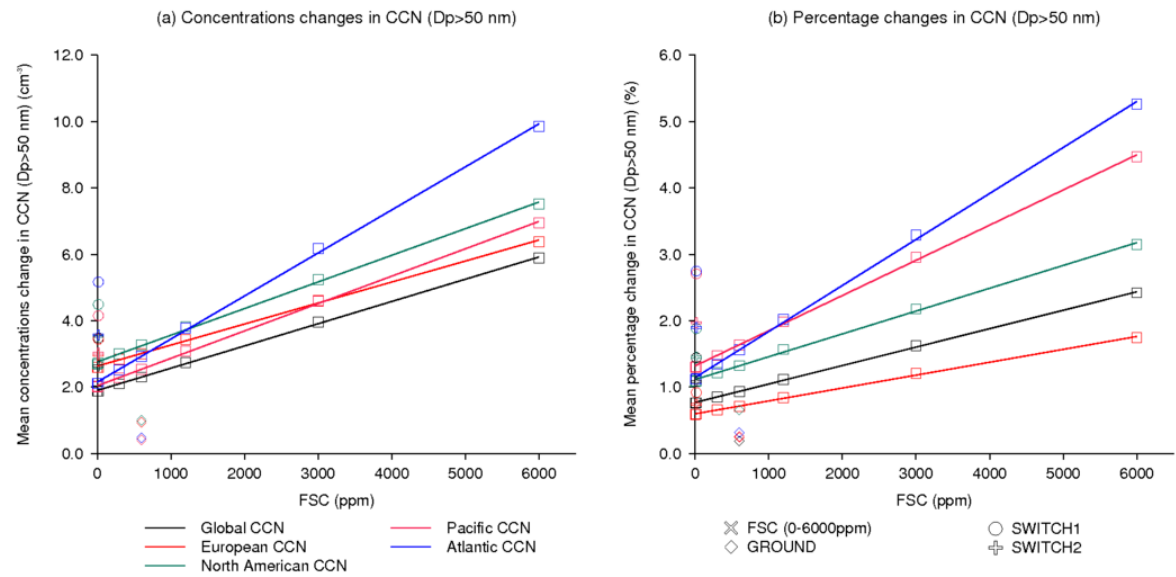
Figure 8. Global and regional variations in low-cloud level (879hPa) CCN ( D p > 50nm): (a) changes in mean concentrations and (b) per- centage changes. See Fig. 5 for definitions of